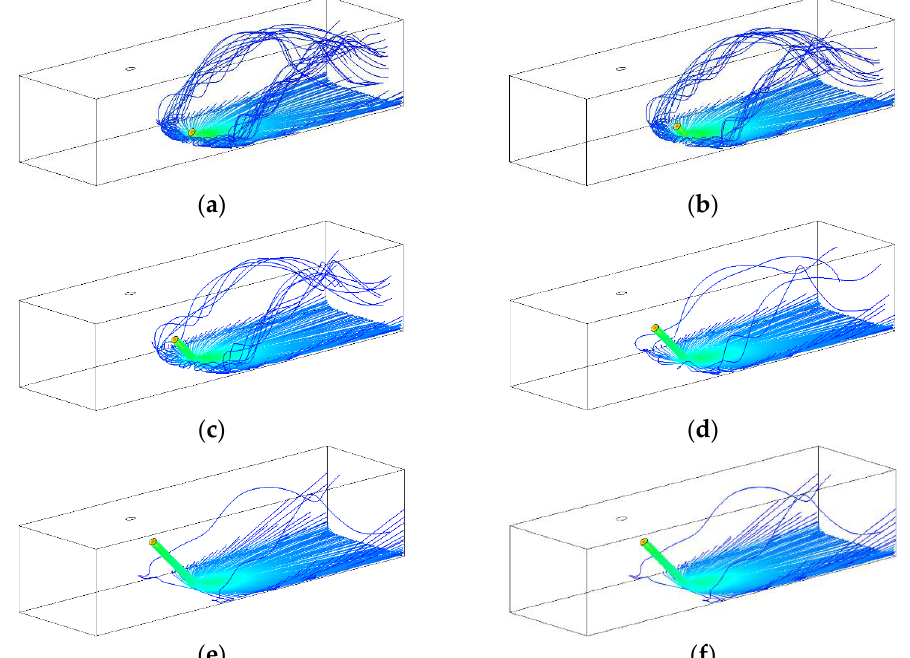
Figure 4. Streamline diagram of oblique submerged impinging jet at various impinging heights: ( a ) H/D = 1; ( b ) H/D = 2; ( c ) H/D = 3; ( d ) H/D = 4; ( e ) H/D = 6; ( f ) H/D = 8. Figure 5 shows the velocity cloud chart and streamline ( Re = 35,100) of the middle section ( y/D = 0) V/V b of the jet at various impinging heights. When the impinging height increases, the jet flow distance between the nozzle and impact plane increases, and the jet diffusion range increases gradually. When H/D ≤ 4, the jet fluid has a greater axial velocity when it reaches the impingement region; when H/D ≥ 6, the axial velocity gradually decreases when it reaches the impingement region. Vortex (C 1 ~C 6 ) is generated near the impact origin in the jet upstream direction ( − x direction), and the vortex center location is consistent, and is almost unaffected by the impinging height.